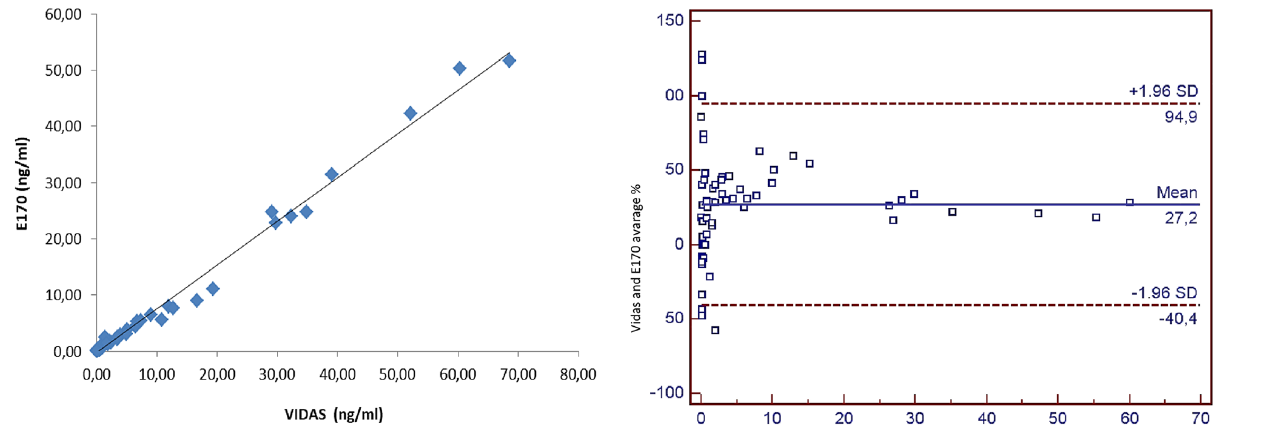
Figure 1: Linear relation graphic of E170 and VIDAS measurement results. Regression equation was found y=0.78x −